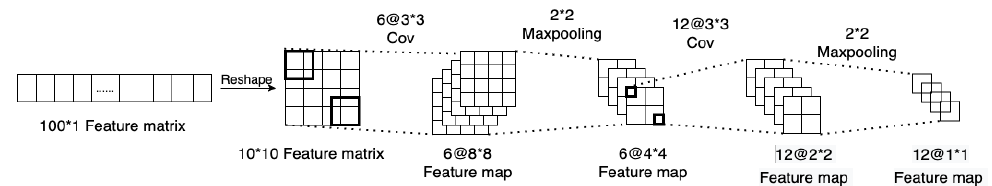
Figure 7. The structure of CNN.